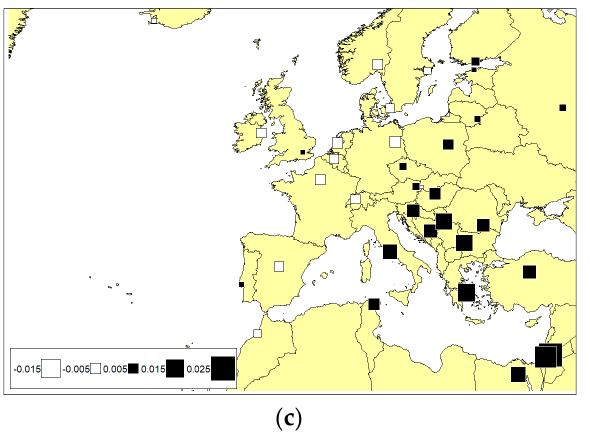
Figure A3. Map of projected second positive PC scores from FASPCA and KNN connection net- work; the smaller map below each bigger map is the zoom-in of Europe: ( a ) period 1; ( b ) period 2; ( c ) period 3.